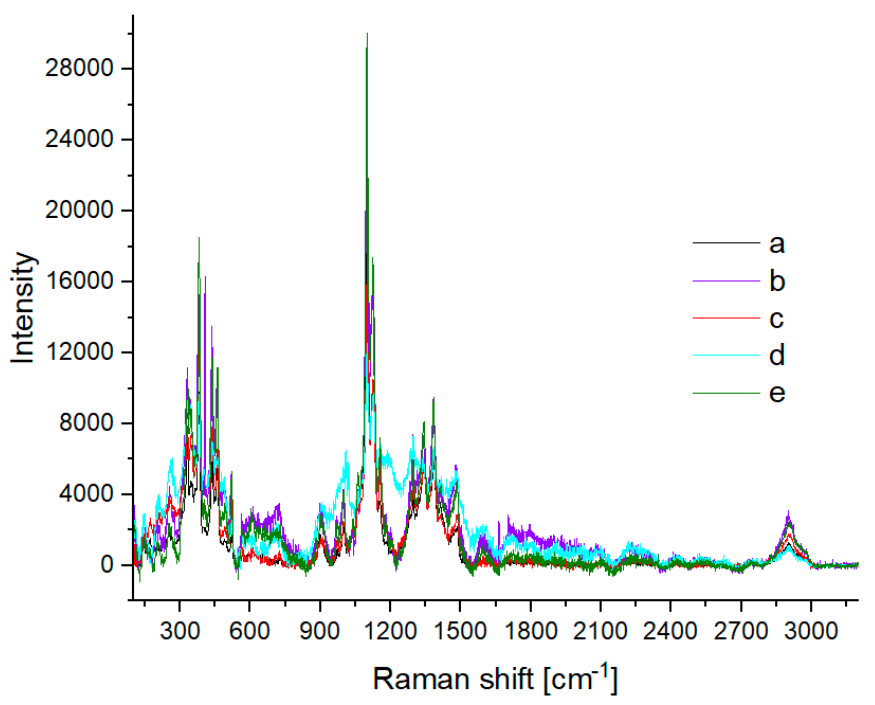
Figure 9. Raman spectra of ( a ) washed cotton and cotton treated at 120 °C for 2 h with various concentrations of H 2 SO 4 : ( b ) 0.5%; ( c ) 2%; ( d ) 5%; ( e ) 10%. concentrations of H 2 SO 4 : ( b ) 0.5%; ( c ) 2%; ( d ) 5%; ( e )